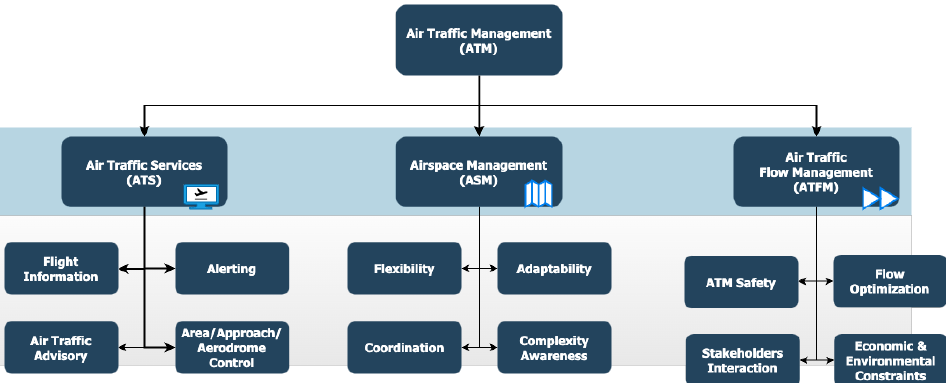
Figure 6. Overview of ATM components